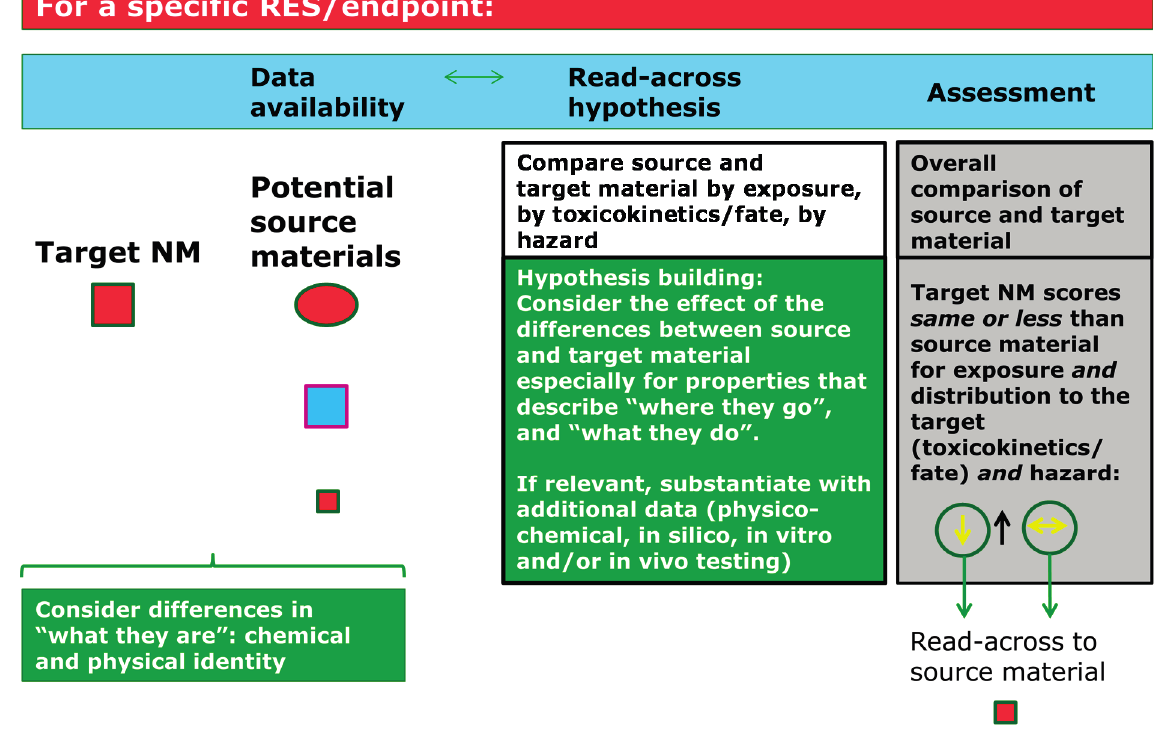
Figure 5. Considerations for a justification of read-across among NMs for a specific relevant exposure route (RES) or endpoint. The differences in chemical and physical identity between target and potential source material(s) are considered in relation to their relevance for affecting exposure, toxicokinetics/fate and hazard. Hypothesis